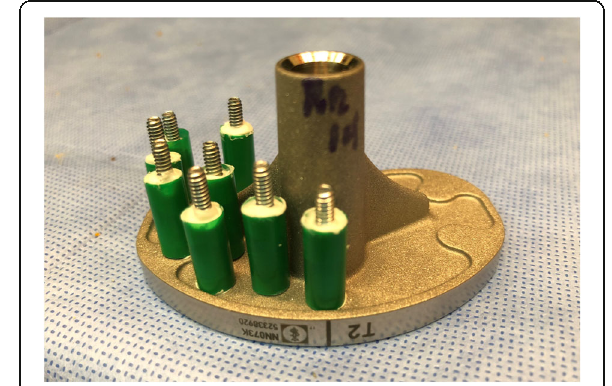
Fig. 2 Tibial tray showing the first phase of dowel application, as many as five cement mixes may be utilized to complete a fully utilized tray